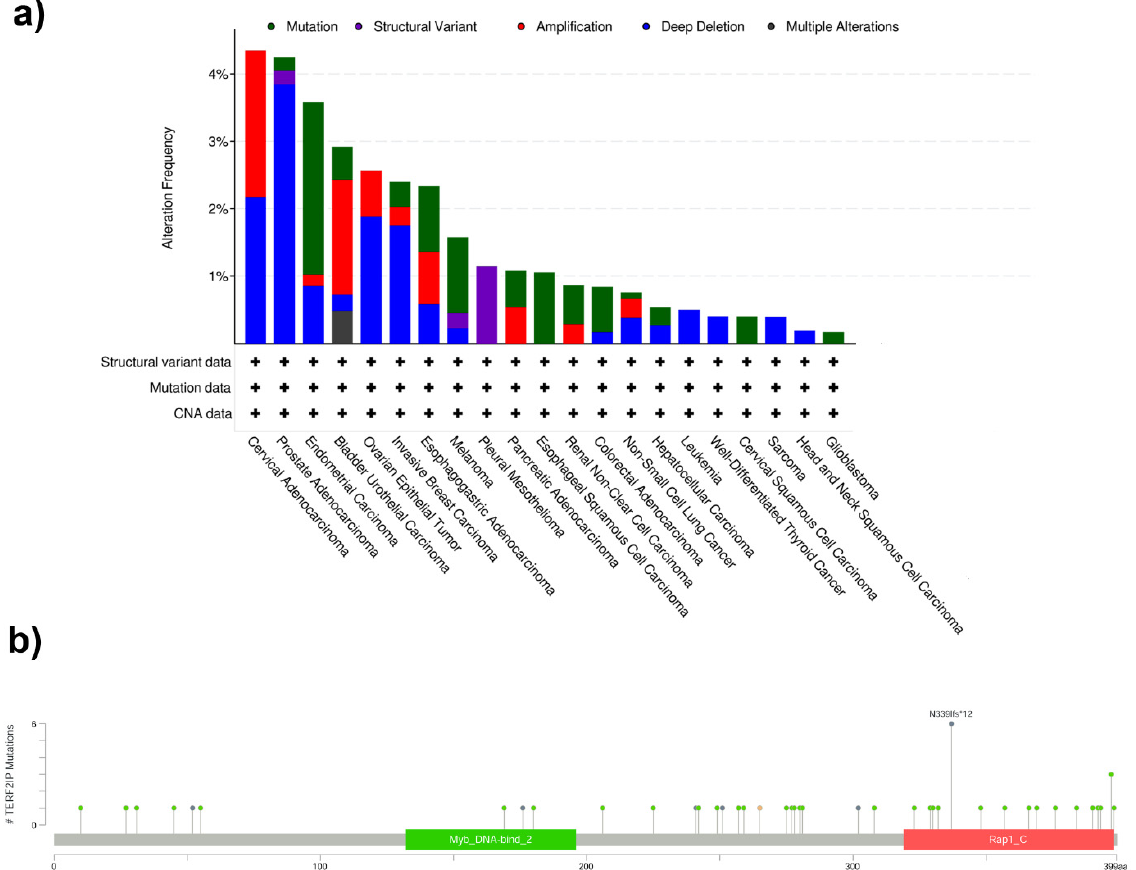
Figure 2. The genetic alterations identified in TERF2IP gene according to cBioPortal [16]. ( a ) Alteration gene frequency including single nucleotide missense mutation (green), structural variant (purple), gene amplification (red), deletion (blue) and multiple genetic alteration (gray) in the various type of cancers. ( b ) Localization of genetic mutation in domain of TERF2IP gene. Colors mean the following genetic alterations: single nucleotide missense mutation (green), splice (orange), truncating variants (gray). Created with cBioPortal (cbioportal.org, accessed on 21 November